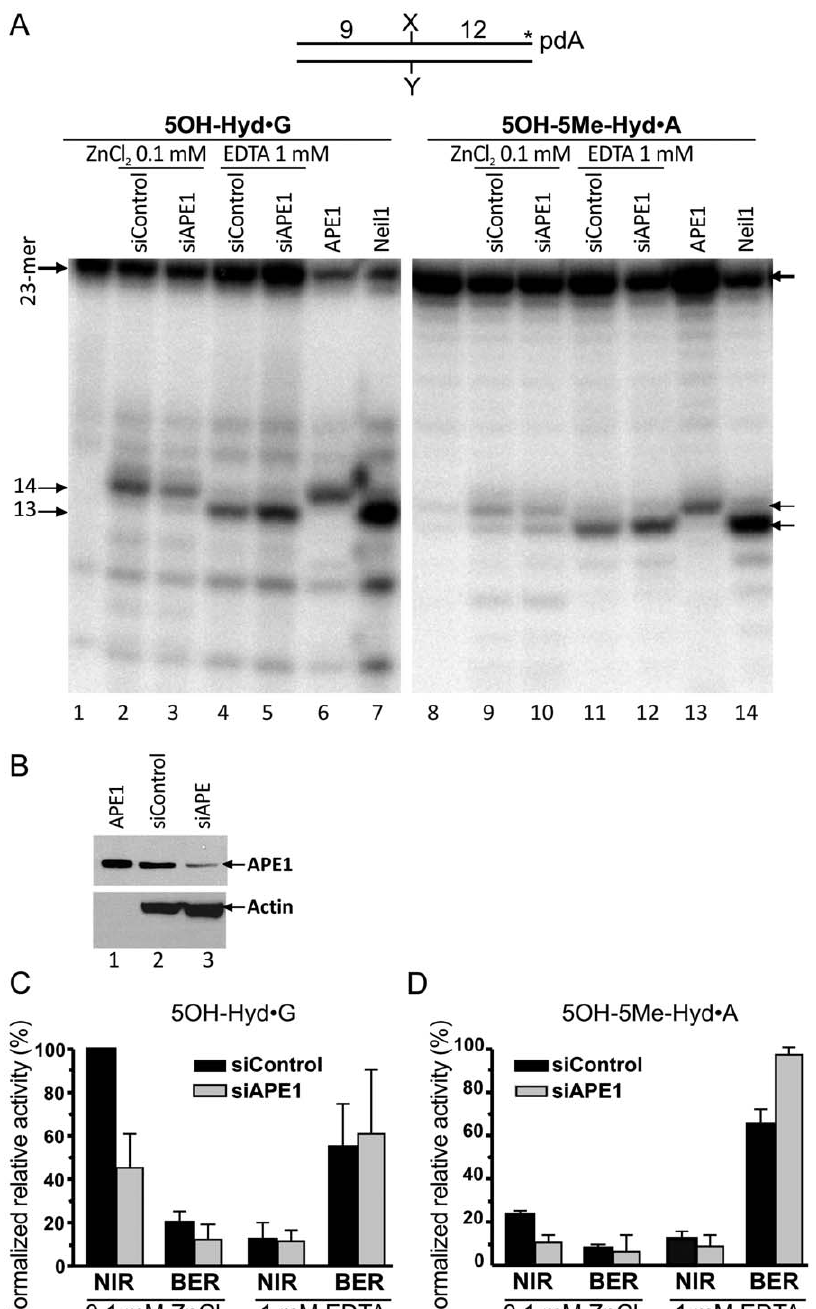
Figure 6. APE1-catalyzed nucleotide incision activity towards pyrimidine-derived hydantoins in HeLa cells extracts. 3 9 -[ a - 32 P]-ddATP- labelled oligonucleotide duplexes were incubated with either 0.5 m g of HeLa cells extract or a purified protein either under ‘‘NIR + Zn 2 + ’’ (lanes 2–3, 6 and 9–10, 13) or under ‘‘BER + EDTA’’ conditions (lanes 4–5, 7 and 11–12, 14) for 1 h at 37 u C. ( A ) Denaturing PAGE analysis of the reaction products. Lane 1, control non-treated 5OH-Hyd N G; lanes 2 and 4, 5OH-Hyd N G incubated with extracts from HeLa cells treated with the non-specific siRNA (100 nM); lanes 3 and 5, 5OH-Hyd N G incubated with extract from HeLa cells treated with the APE1-specific siRNA (100 nM); lane 6, 5OH-Hyd N G treated with 1 nM APE1; lane 7, 5OH-Hyd N G treated with 5 nM NEIL1; lanes 8–14, same as 1–7 but with 5OH-5Me-Hyd N A as a substrate. ( B ) Western blot analysis of siRNA-induced down-regulation of the APE1 expression in HeLa cells. ( C ) Graphic representation of the mean values of DNA glycosylase (BER) and AP endonuclease (NIR) activities in extracts, representing amounts of the 13-mer and 14-mer products, respectively. The cleavage activities in each cell free extract were normalized to the relative densitometry values of actin bands on western blot in panel B. For details see Materials and Methods.